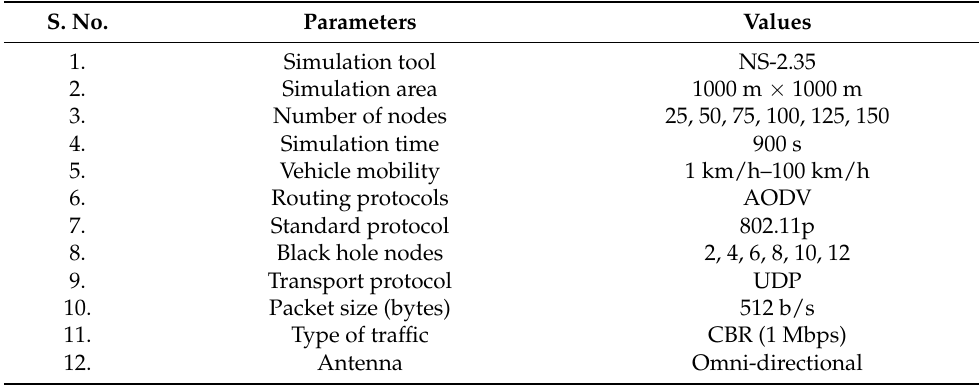
Figure 9. Initial state of the first experiment. Table 5. Simulation